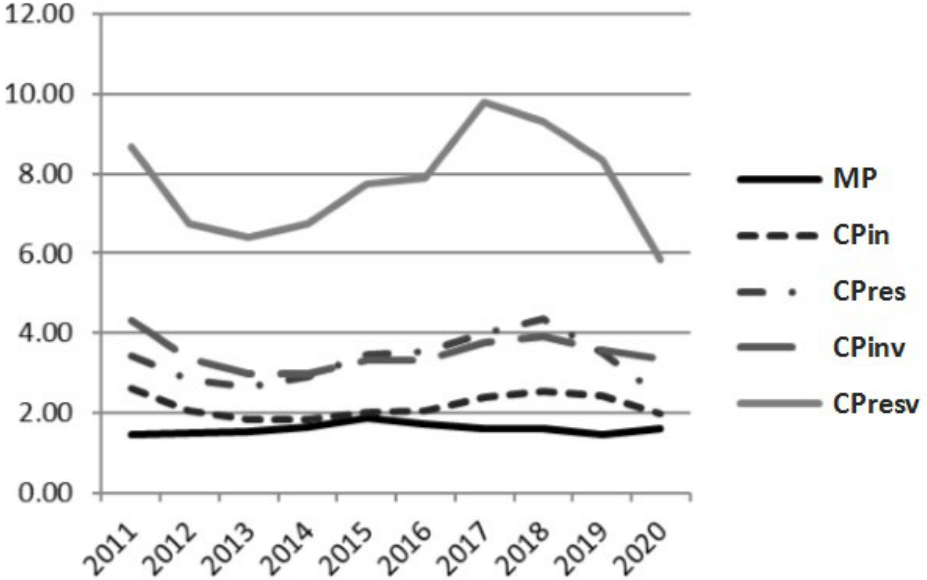
Figure 4. Material and capital productivity value dynamics for the PJSC “Severstal”. MP—material productivity; CPinev—indicator calculated based on initial CP values of machinery and equipment; CPresev—indicator calculated based only on the residual cost of the machinery and equipment.